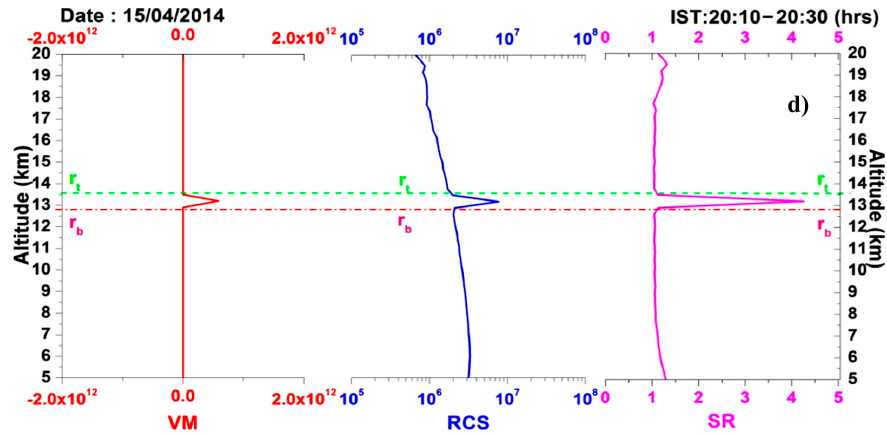
Figure 2. ( a ) Typical Variance Method profile for multiple layer cirrus clouds corresponding to the Range Corrected Signal and Scattering Ratio along with the detected altitudes of cirrus cloud layer bases (pink-red color dash-dotted line) and tops (green color dashed line) on 21 / 11 / 2014 between 23:09 and 23:29, Indian Standard Time (IST); ( b ) Same as ( a ) but for the dual layer cirrus clouds on